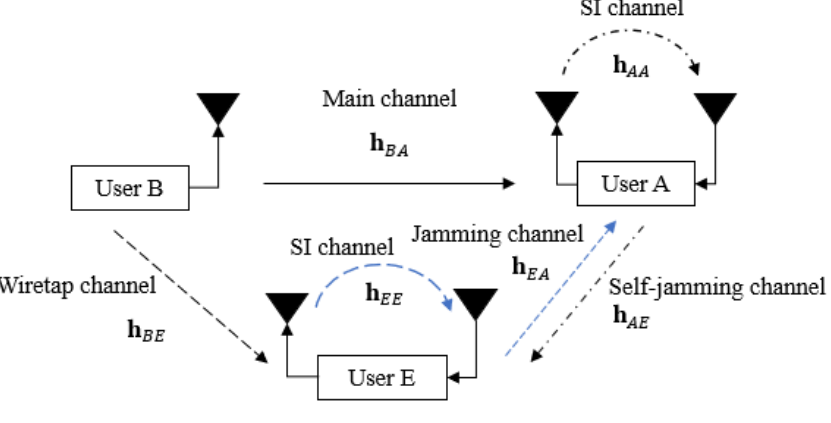
Figure 1. General system